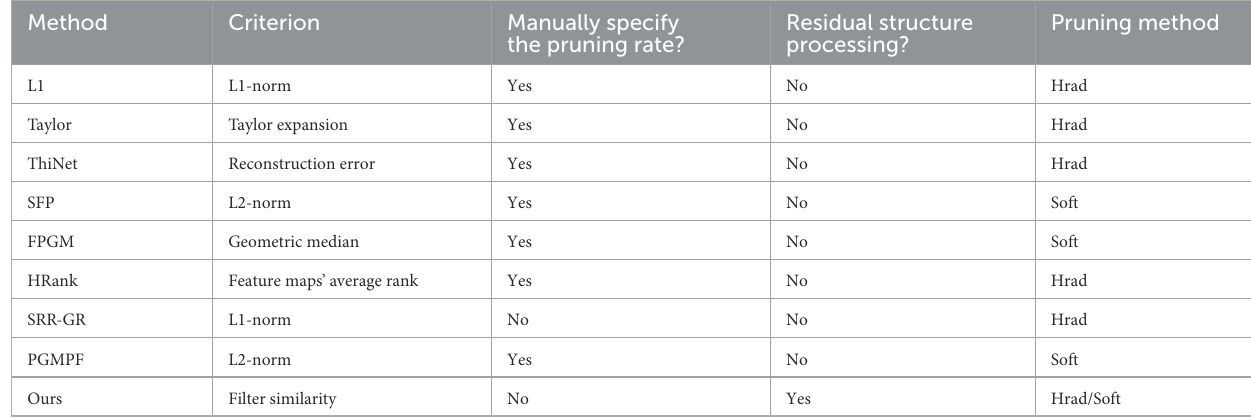
TABLE 1 Comparison of our proposed method with current